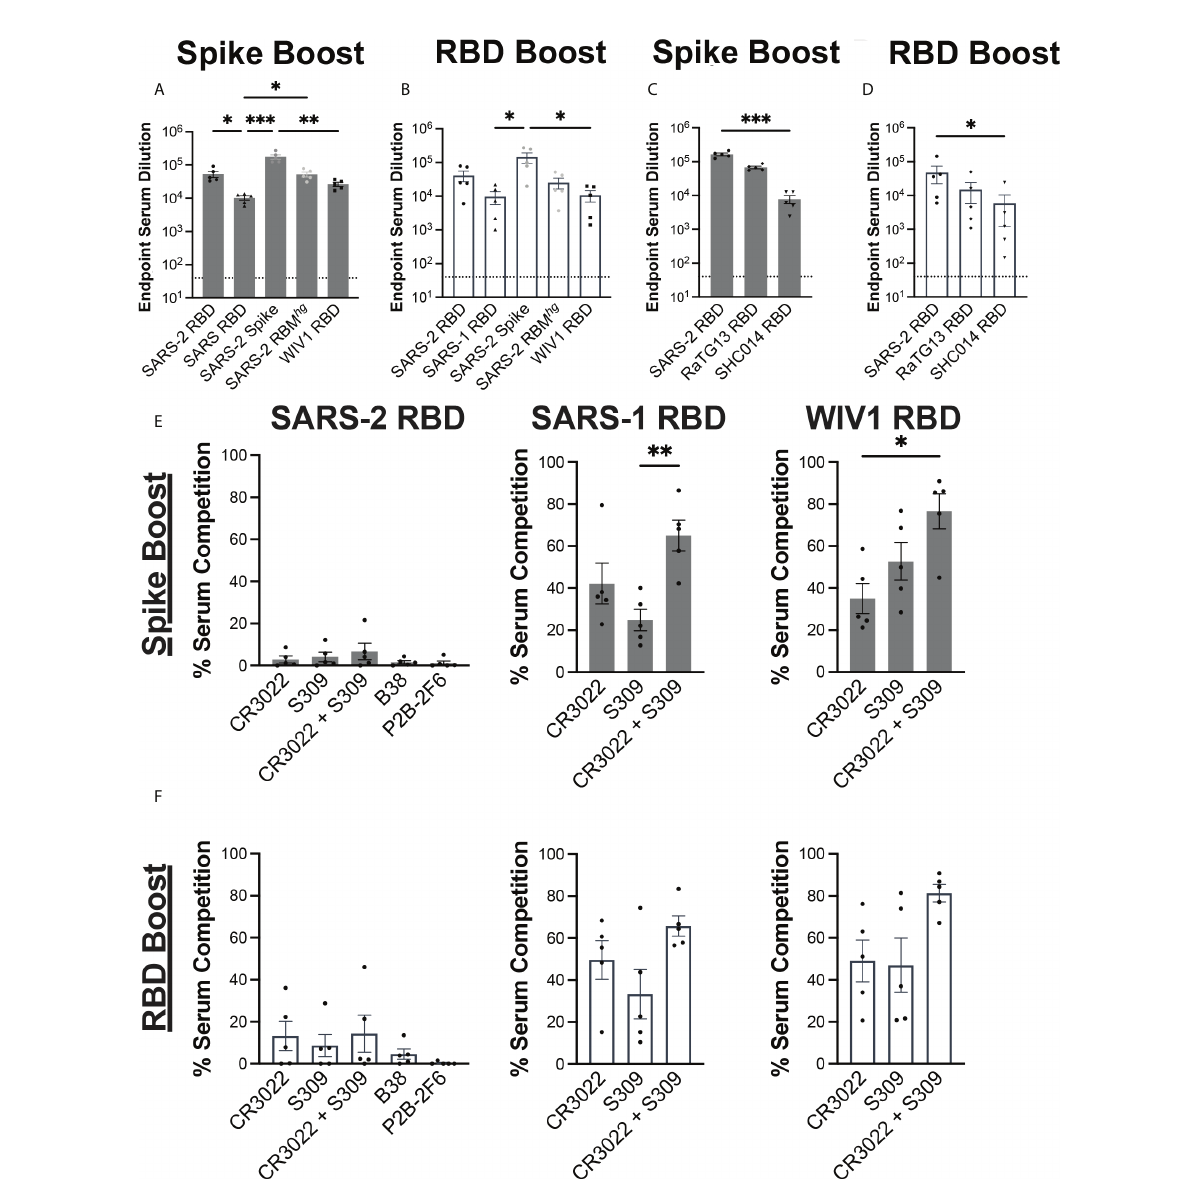
FIGURE 2 Serum response to immunization regimens. Serum collected at day 35 from the Spike Boost cohort (A) and the RBD boost cohort (B) was assayed in ELISA different coronavirus antigens. (C, D) Additional ELISAs were performed using day 35 serum samples against RaTG13 and SHC014 RBDs. (E, F) Percent of day 35 serum antibody binding lost in competition ELISAs compared to a no IgG control. SARS- 2, SARS-1, and WIV1 RBDs were used as coating antigens. Statistical signi fi cance across all panels was determined using Kruskal-Wallis test with post-hoc analysis using Dunn ’ s test corrected for multiple comparisons (*p < 0.05, **p < 0.01, ***p < 0.001). All pairwise comparisons were performed, and only statistically signi fi cant comparisons are indicated on the